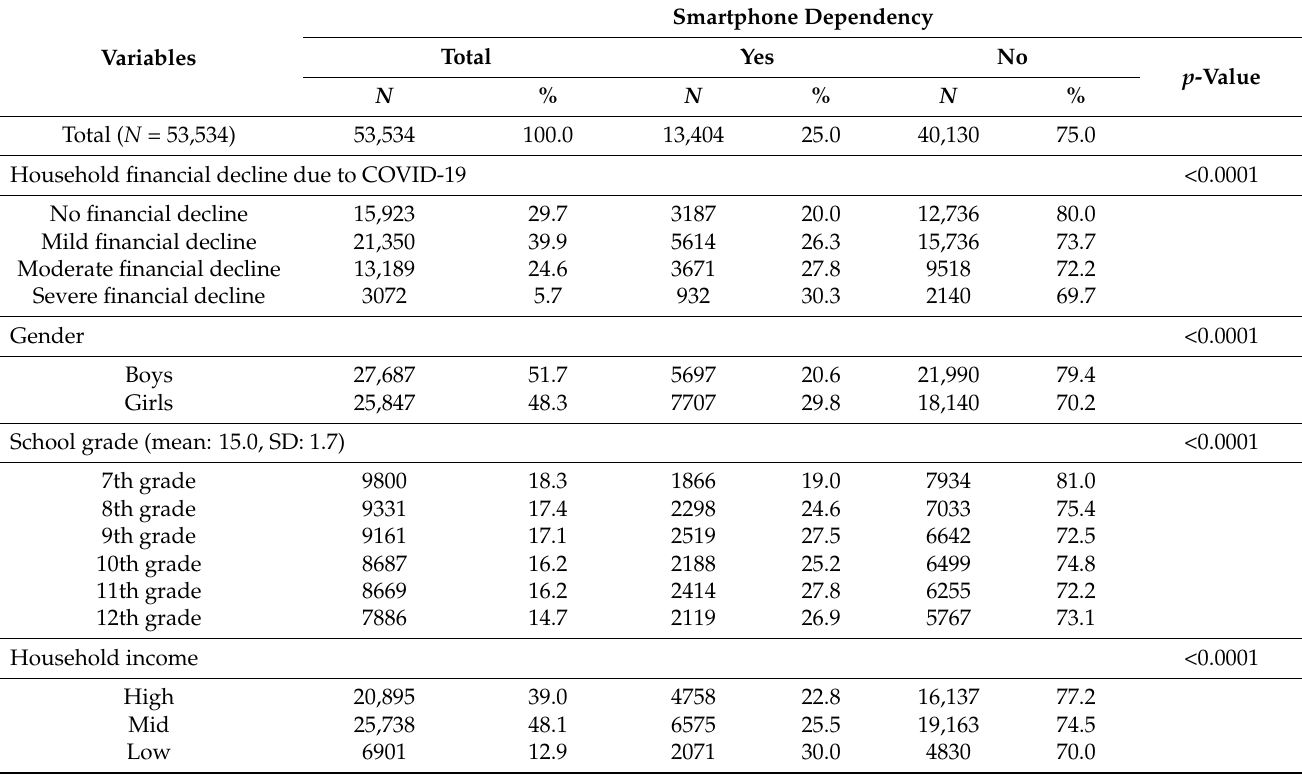
Table 1. General characteristics of the study